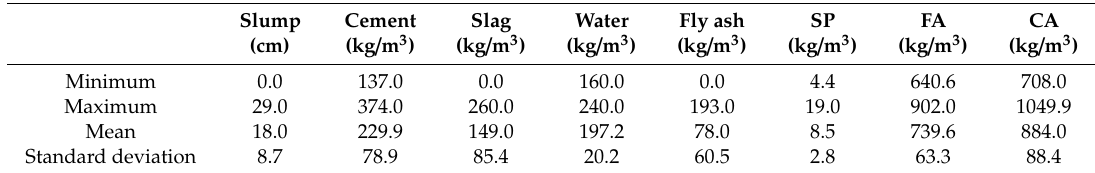
Table 1. Statistical analyses of the used dataset.